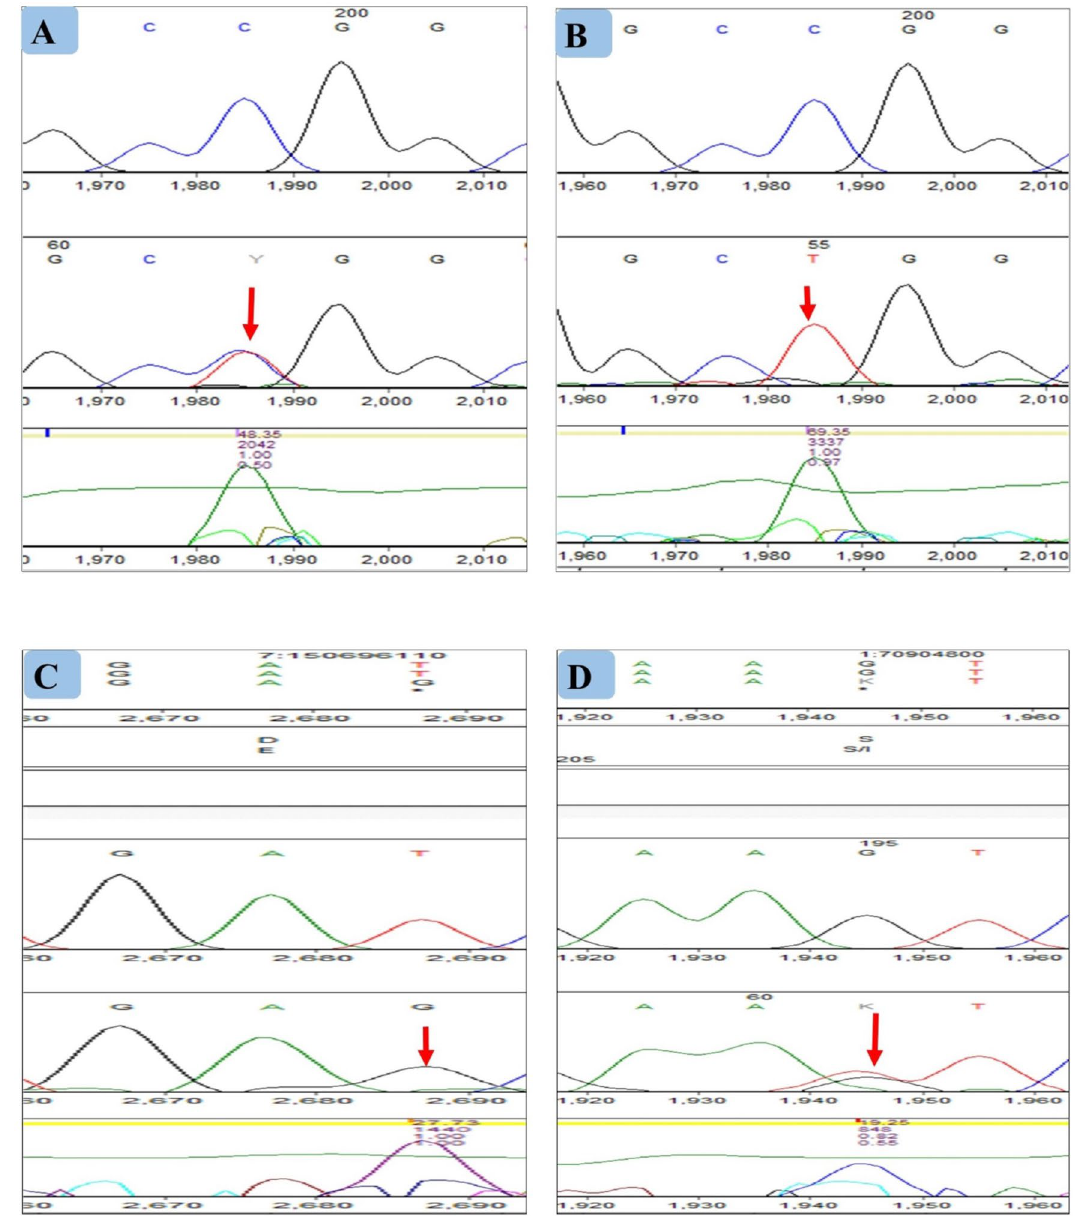
Figure 6. Graphical display of identified SNPs in eNOS and CSE gene (Sanger sequencing and analysis by mutation Surveyor software version 5.1. intronic mutation (VNTR4). Line 1 represents the forward reference trace Line 2 the patient DNA trace and line 3 the mutation trace and the arrow show the nucleotide substitution. ( A ) shows the heterozygous mutation -786T>C (c.-51-762C>T). ( B ) homozygous (T-786C) (c.-51-762C>T). ( C ) homozygous mutation in SNP G896T that leads to amino acid change (Glu298ASP) and ( D ) shows the mutation in SNP (364G-T) of the CSE gene that leads to amino acid change